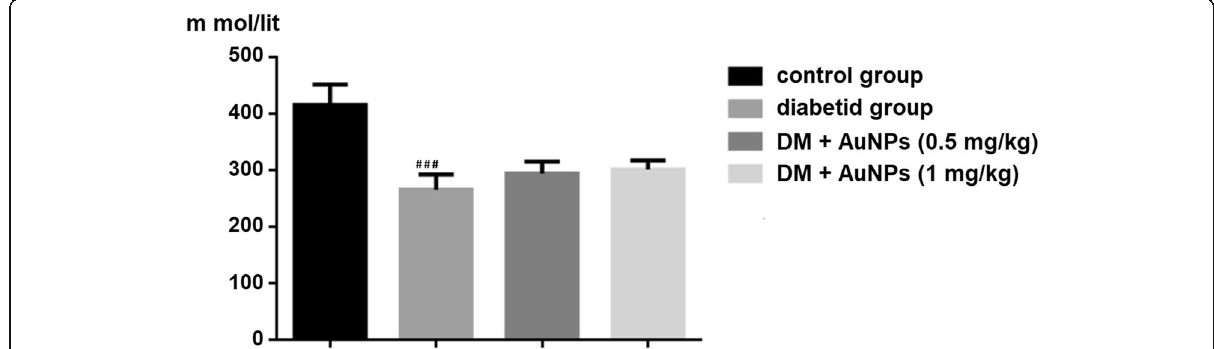
Fig. 8 Effect of AuNPs on Plasma thiol groups experimental groups of rats after 21 days treatment. Data are reported to mean ± SD of 5rats in each group. *, **,***,and****represent statistically significant differences from Diabetic group at p < 0.05, 0.01,0.001 and 0.0001, respectively. #, ##, ###, and ####represents statistically significant difference from control group at p < 0.05, 0.01,0.001 and 0.0001,